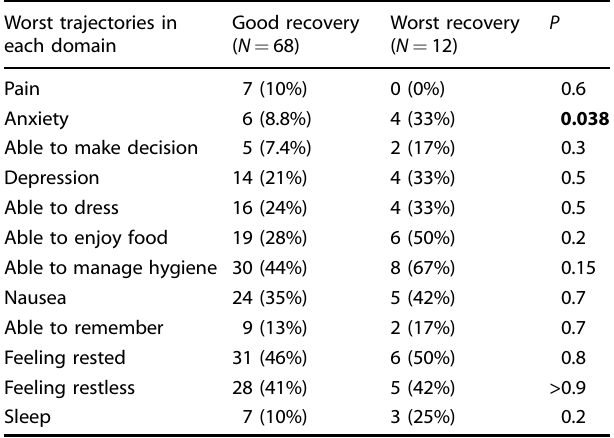
Table 2. Associations between belonging to the worst overall recovery trajectory vs. worst trajectories in other